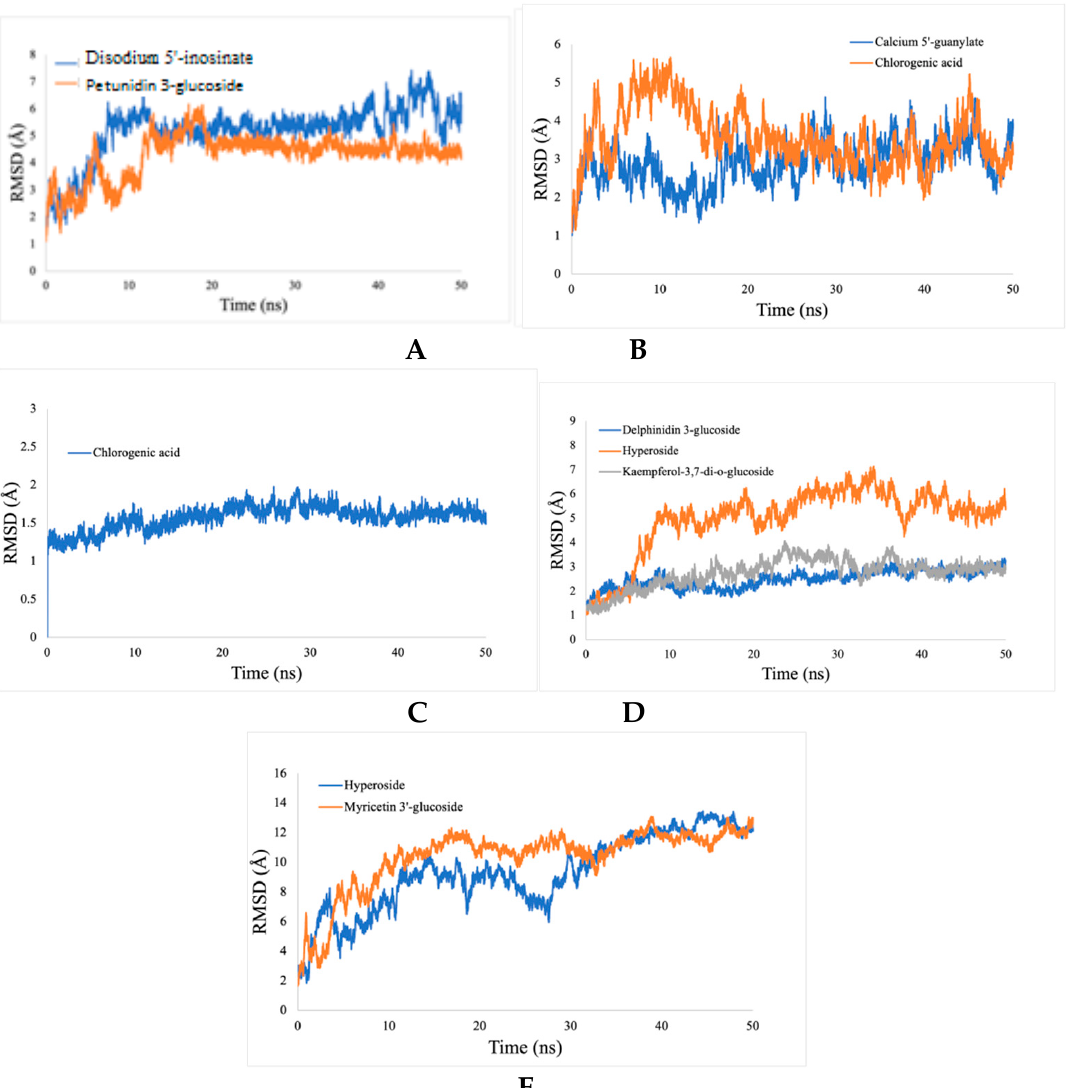
Figure 10. RMSD analyses of protein-ligand complexes. ( A ) acetylcholine esterase, ( B ) actin, ( C ) α -tubulin, ( D ) arginine kinase, and ( E ) histone subunit III with inhibitors (disodium 5 ′ -inosinate and petunidin 3-glucoside), (calcium 5 ′ -guanylate D and chlorogenic acid), chlorogenic acid, (kaempferol-3,7-di-O-glucoside I, hyperoside D, delphinidin 3-glucoside ID) and (myricetin 3 ′ - glucoside ID, hyperoside D), respectively.